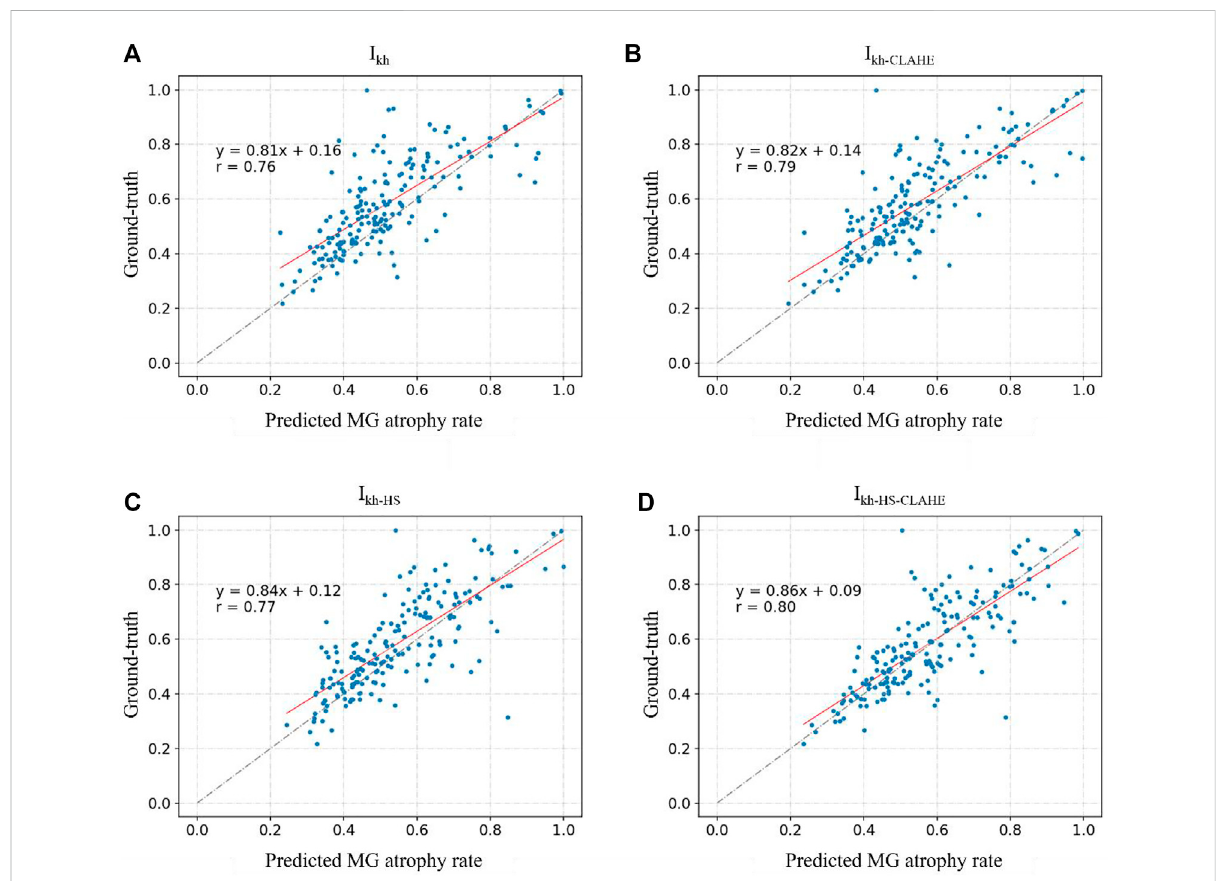
FIGURE 6 (A – D) represent the direct comparison of the ground truth and predicted MG atrophy rates of the unprocessed image set Ikh, image set Ikh- CLAHE processed with CLAHE, image set Ikh-HS processed with HS, and image set Ikh-HS-CLAHE processed with HS and CLAHE, respectively.